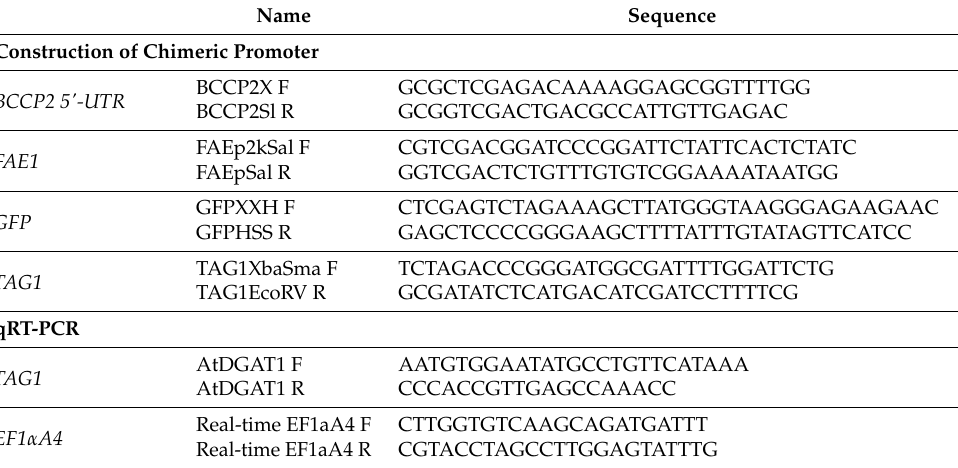
Table 1. Primers used in this